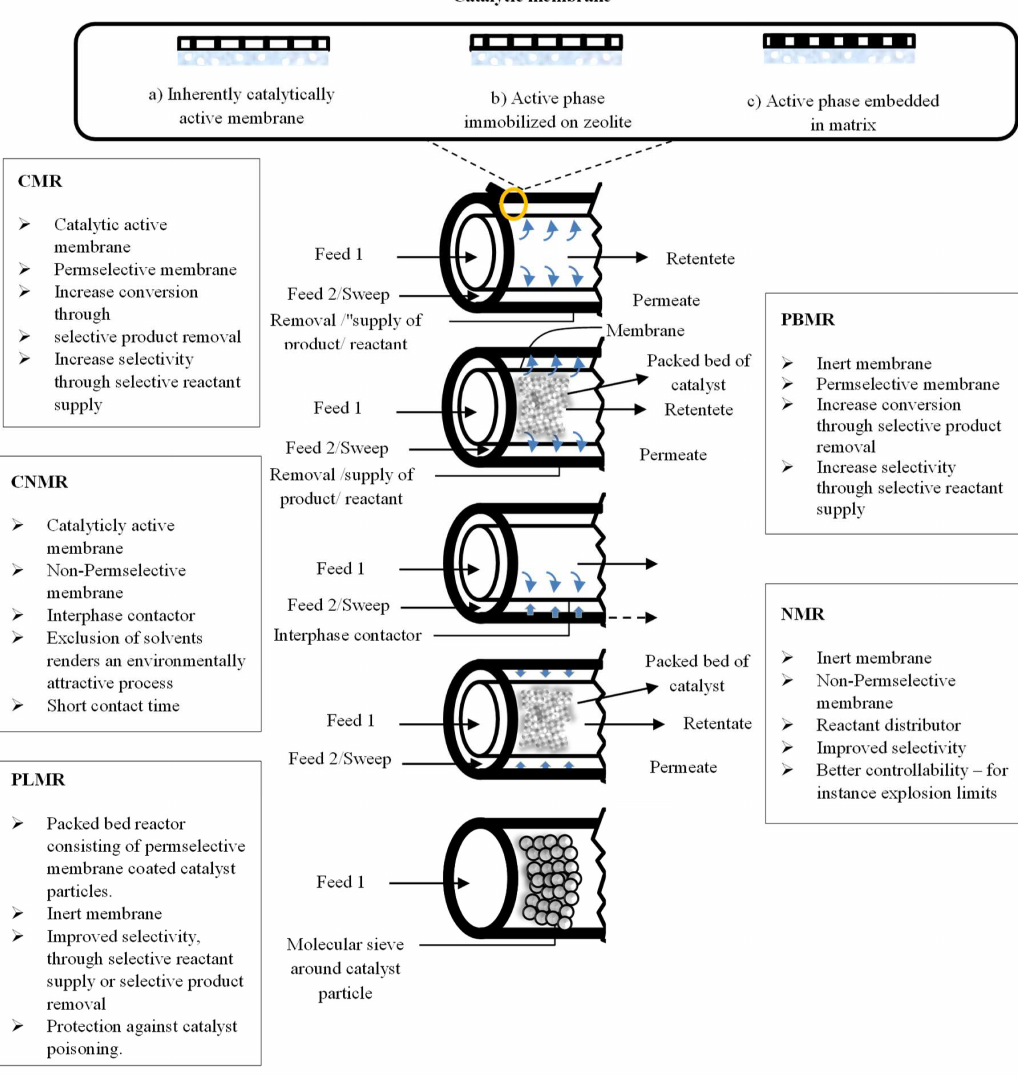
Figure 6. Tubular MRs classification based on the membrane function and its position.